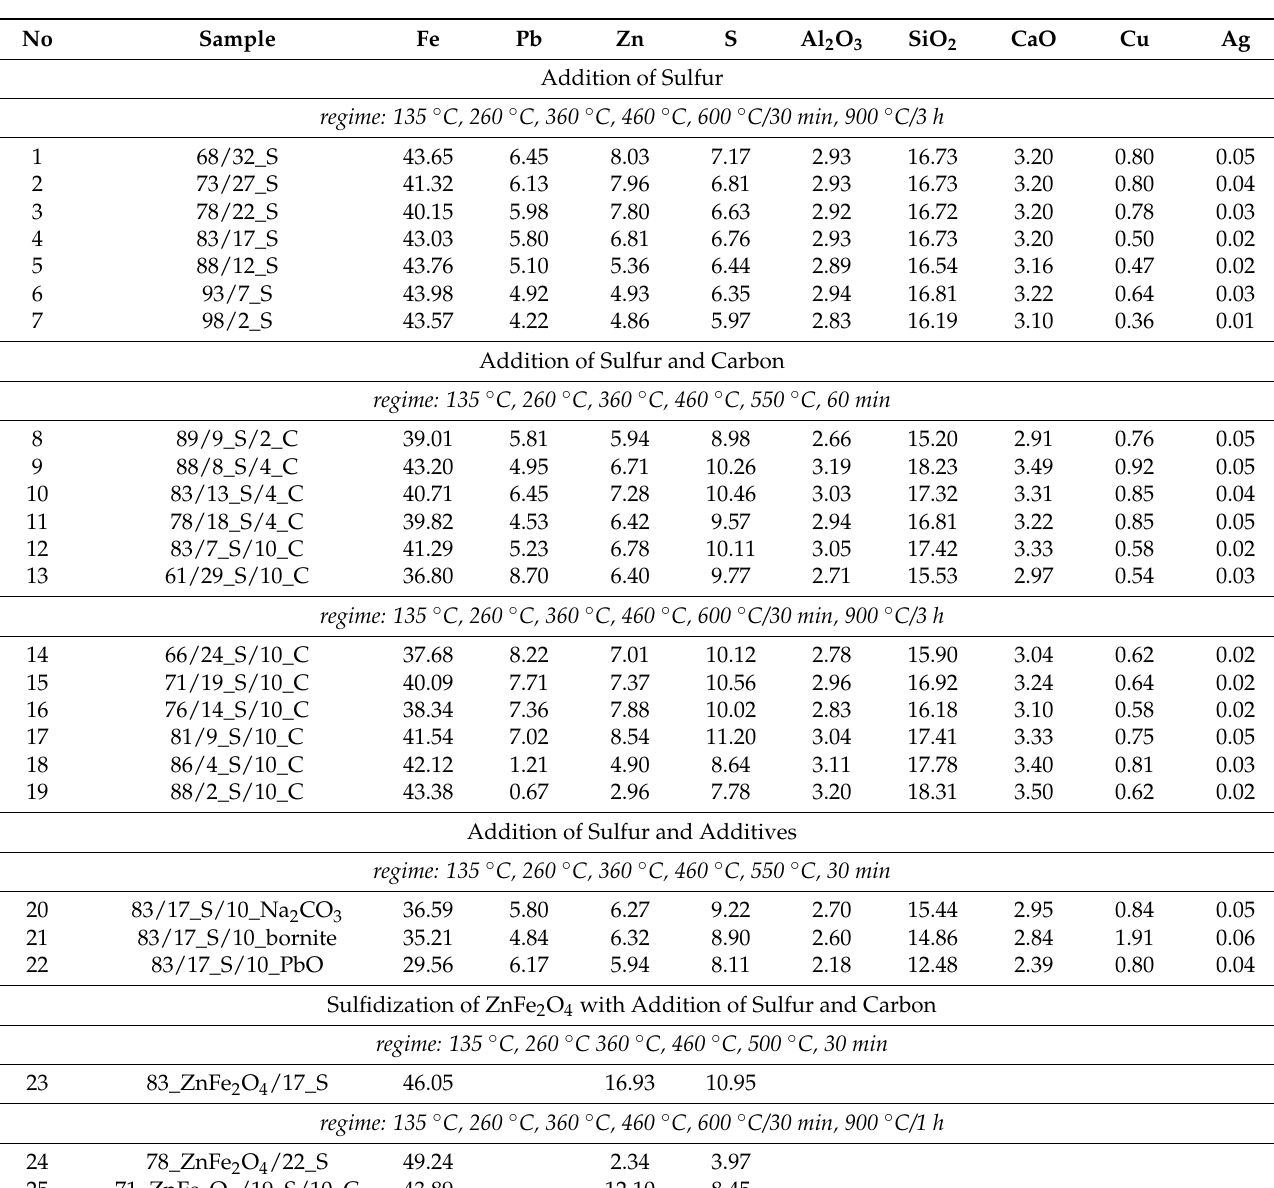
Chemical composition and weight loss for sulfidized samples are presented in Table 6 for various charge compositions and process parameters. Table 6. Chemical composition (wt.%) and weight loss ( ∆ m) of sulfidized jarosite-PbAg